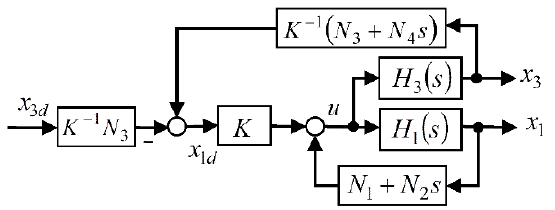
Figure 4. Equivalent state-feedback linearized CIP control system. The GTC associated with (10) and (27) are given, respectively,